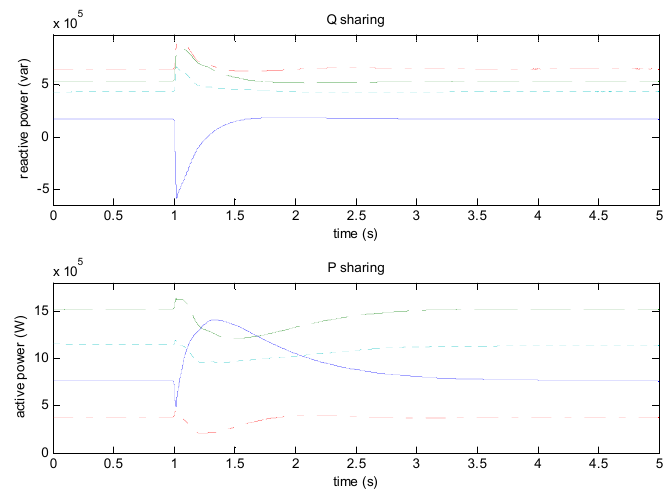
Figure 11. Communication graph of proposed consensus based control.